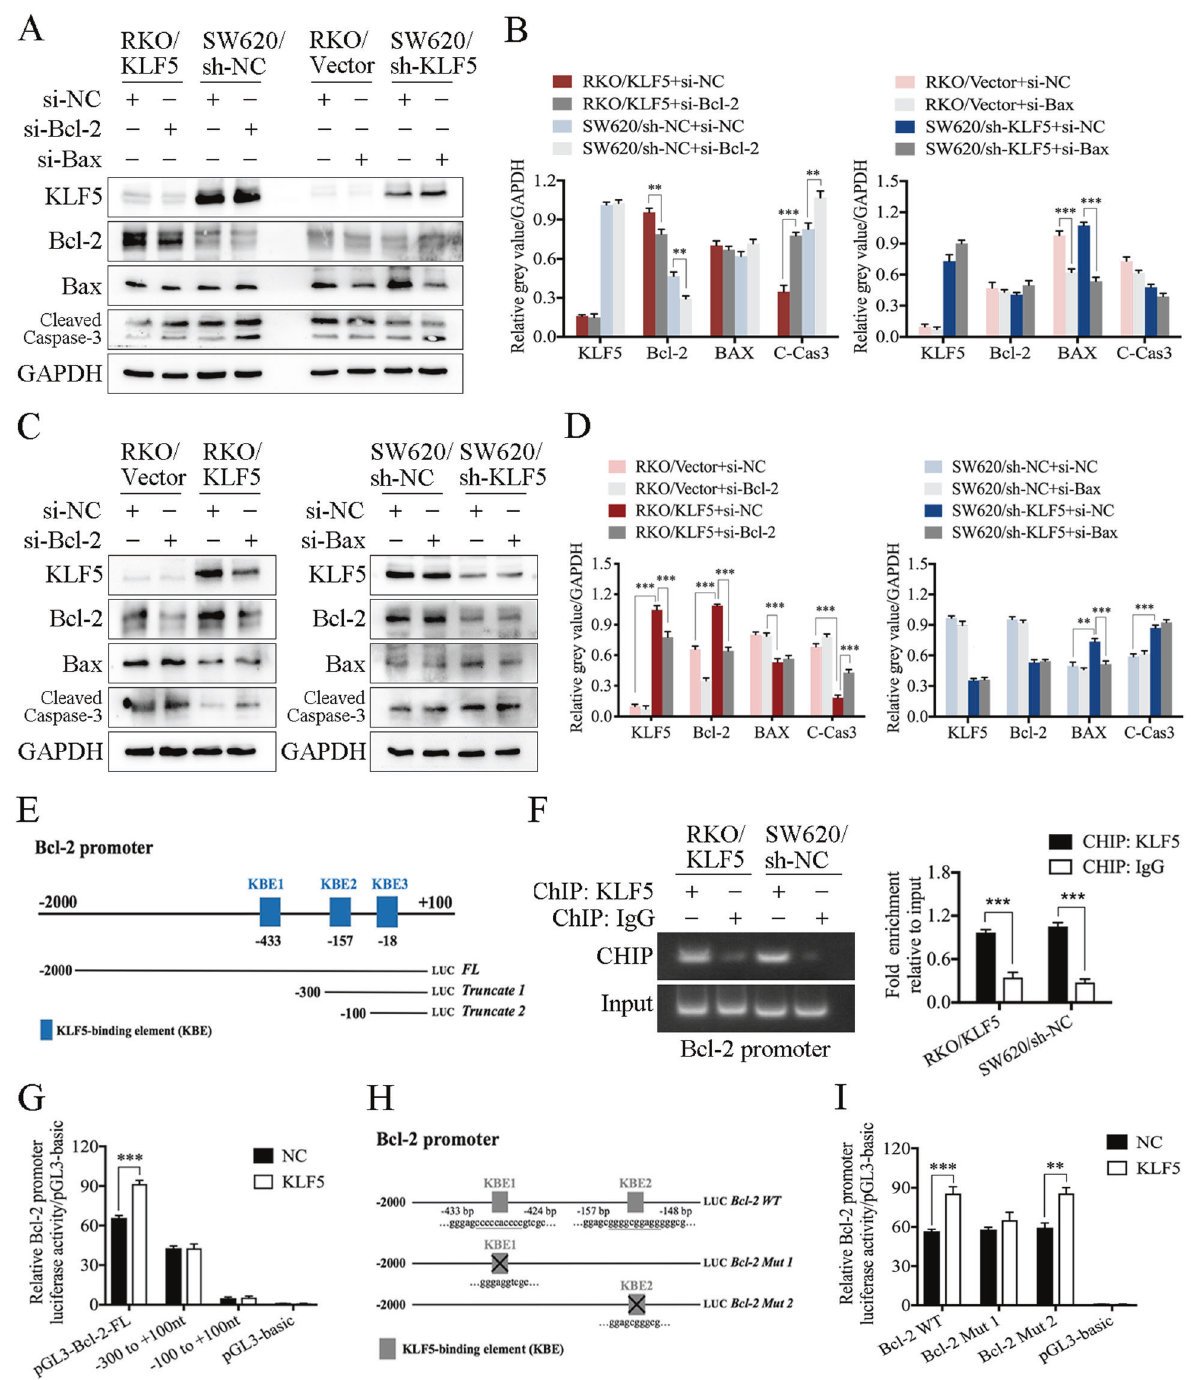
Fig. 5 The KLF5/Bcl-2/caspase 3 signaling pathway affects the oxaliplatin-induced apoptosis of CRC cells. A Western blotting of KLF5, Bcl- 2, Bax, cleaved caspase 3 in CRC cell lines. B Knocking down Bcl-2 signi fi cantly promoted the expression of cleaved caspase 3, whereas knocking down Bax did not affect the expression of Bcl-2 or cleaved caspase 3 (mean ± SD, n = 3 for each group, Student ’ s t -test, ** P < 0.01, *** p < 0.001). C , D Western blotting showed that inhibiting Bcl-2 can reverse the function of KLF5 in suppressing the expression of cleaved caspase 3, whereas inhibiting Bax cannot reverse the function of KLF5 in cleaved caspase 3 suppression (mean ± SD, n = 3 for each group, one- way ANOVA, ** P < 0.01, *** p < 0.001). E KLF5-binding elements (KBE1 to KBE3) on Bcl-2 promoter region. F ChIP veri fi ed the direct binding of KLF5 to the predicted site (KBE1) of the Bcl-2 promoter (mean ± SD, n = 3 for each group, Student ’ s t -test, *** p < 0.001). G The results of luciferase reporter assay showed that KLF5 only promoted the luciferase activity of pGL3-Bcl2-FL (mean ± SD, n = 3 for each group, Student ’ s t - test, *** p < 0.001). H Schematic diagram showed the mutation site of Bcl-2 Mut 1 and Bcl-2 Mut 2 plasmids. I The results of luciferase reporter assay showed that KLF5 could not promote the luciferase activity of Bcl-2 Mut 1, which did not contain KBE1 sequence (mean ± SD, n = 3 for each group, Student ’ s t -test, ** P < 0.01, *** p <